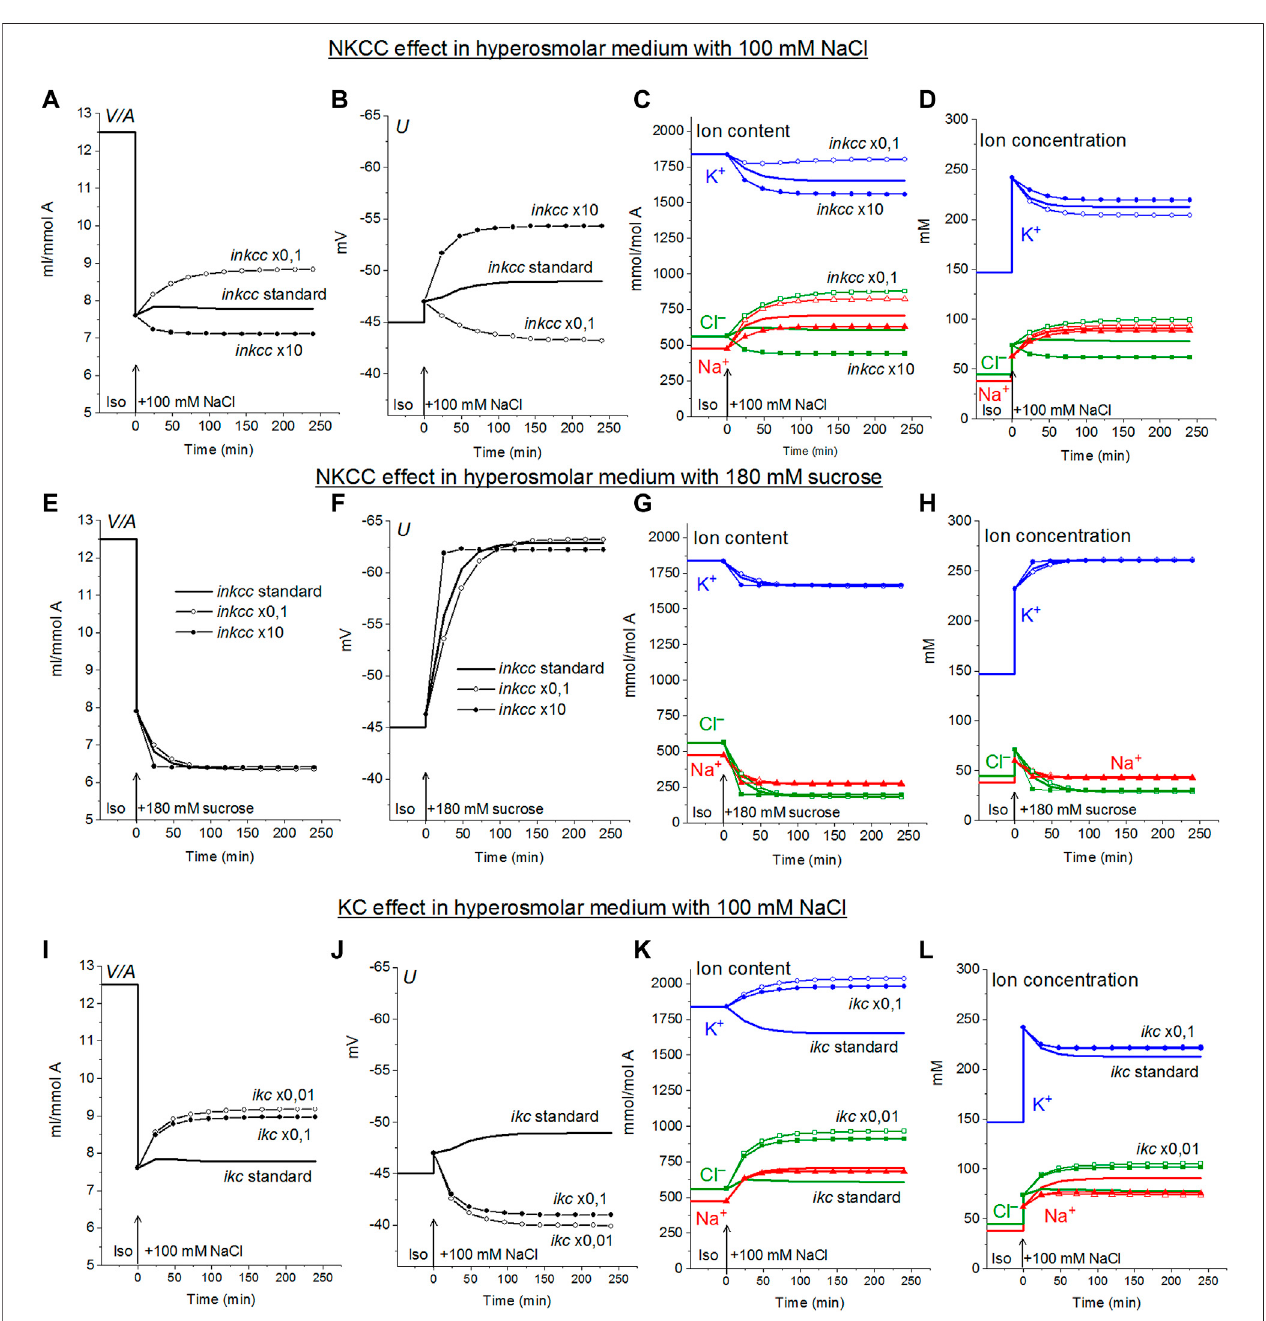
FIGURE4 | Dependence ofionic homeostasisin U937 cell model during transitionto hypertonic medium with 100 mM NaCl (A – D , I – L) or 180 mM sucrose (E – H) on the rate coef fi cients inkcc (A – H) and ikc (I – L) , changing simultaneously with external osmolarity. The calculation was carried out for a model with a full set of cotransporters. Changes in NKCC and KC rate coef fi cients are shown in the graphs, other parameters remain unchanged and are shown in Table 2 .